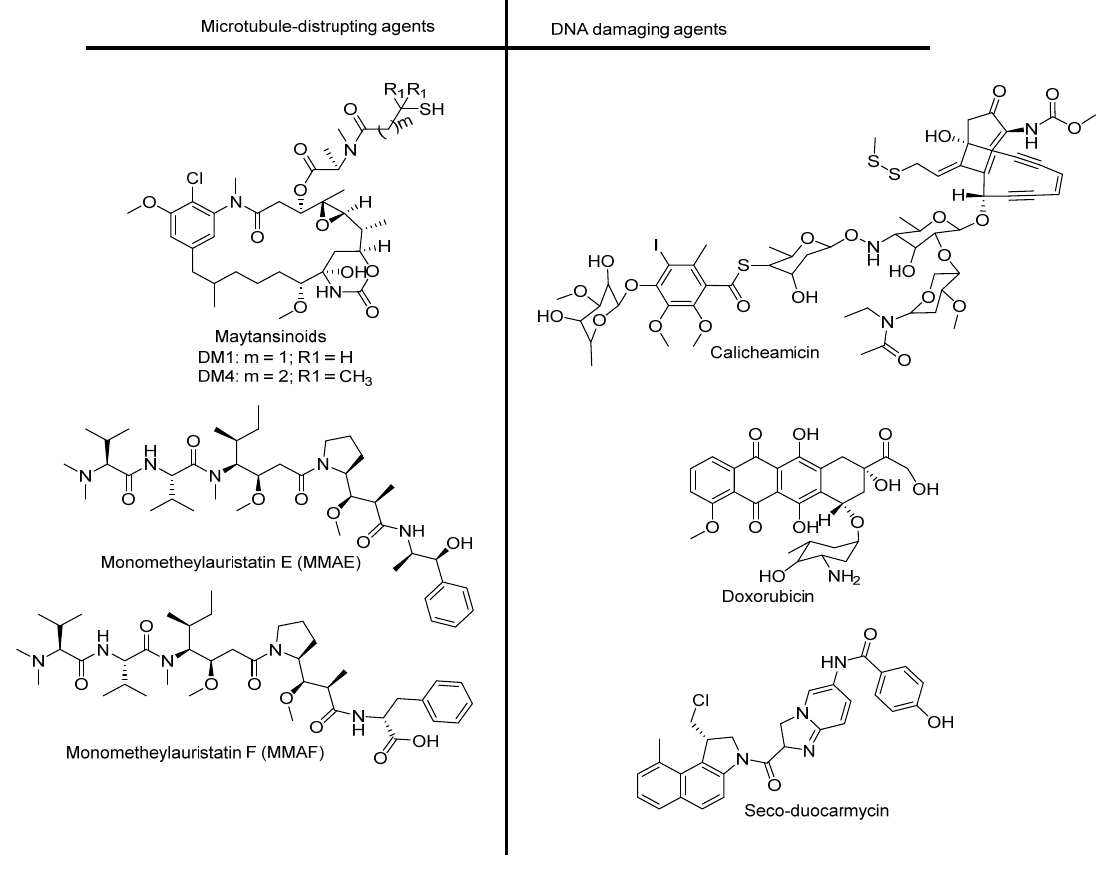
Figure 2. Cytotoxic drugs used in ADC